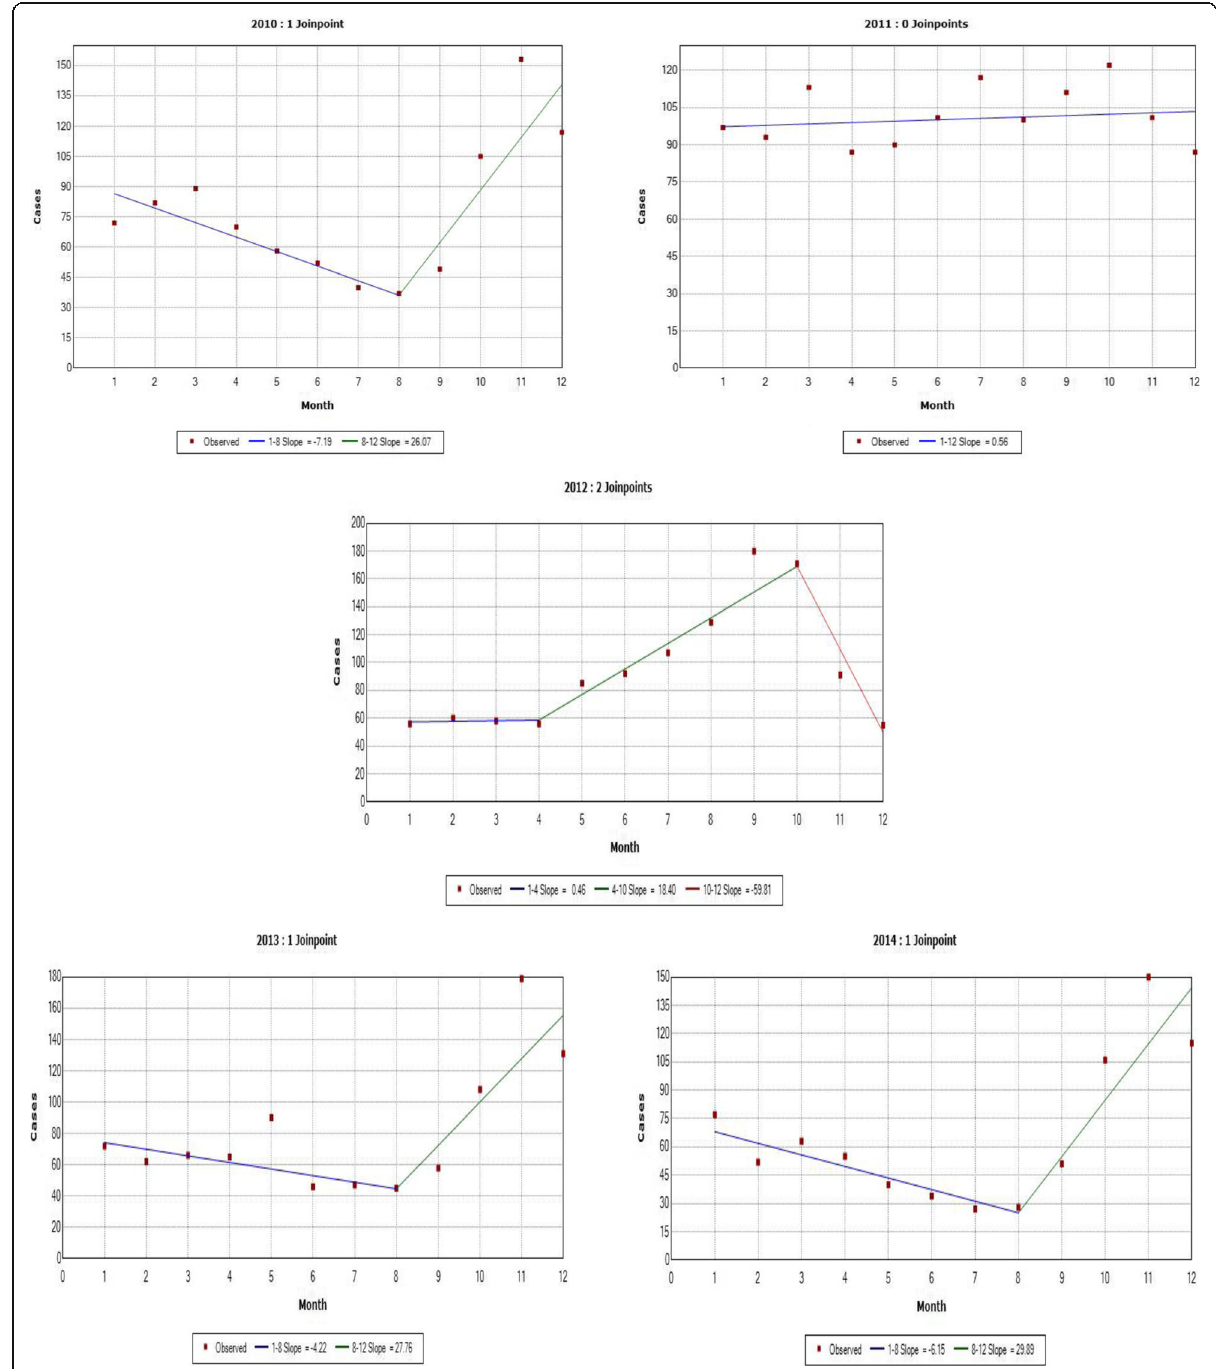
Fig. 1 Joinpoint regression analysis of monthly cumulative frequency of bronchiolitis hospitalizations by year, 2010 –